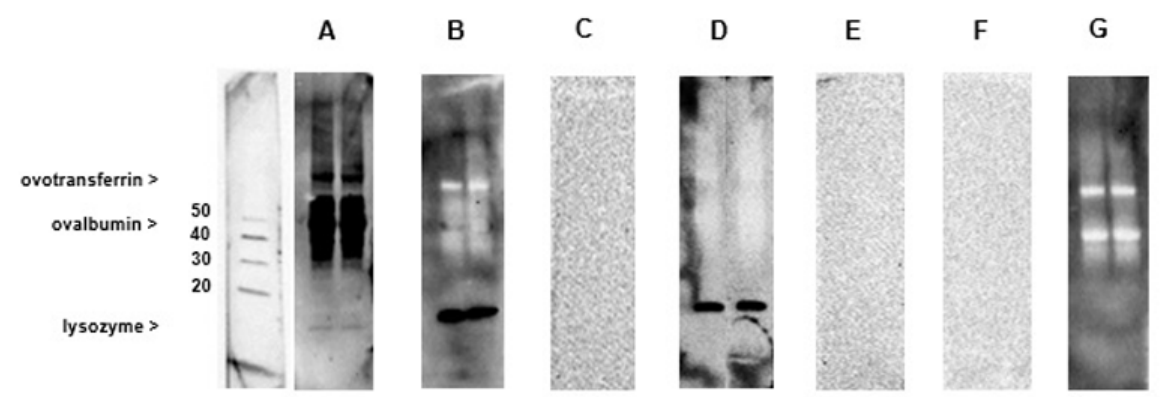
Figure 2. Evaluation of horseradish peroxidase hyperactivation by polyphenols. Western blot strips of ( A ) unmodified egg white proteins and ( B – G ) egg white protein-green tea polyphenol aggregate particles containing 15% total polyphenol content, after various immunoblotting treatments. ( B ) received all immunoblotting reagents after membrane blocking - primary antibody (pooled human plasma from 7 egg white allergic individuals with egg white-specific IgE levels ranging from 15.4 to 100 kU L −1 ), biotinylated goat IgG anti-human IgE secondary antibody, NeutrAvidin HRP conjugate, and substrate; ( C ) the secondary antibody and NeutrAvidin HRP conjugate were omitted; ( D ) the primary antibody was omitted and ( E ) the primary and secondary antibody and NeutrAvidin HRP conjugate were omitted; ( F ) the primary antibody and NeutrAvidin HRP conjugate were omitted and ( G ) the primary antibody and secondary antibody were omitted. A molecular weight marker (kDa) is shown on the far left. Approximate locations for egg white allergens are indicated. Gray scale was used and contrast was optimized to improve